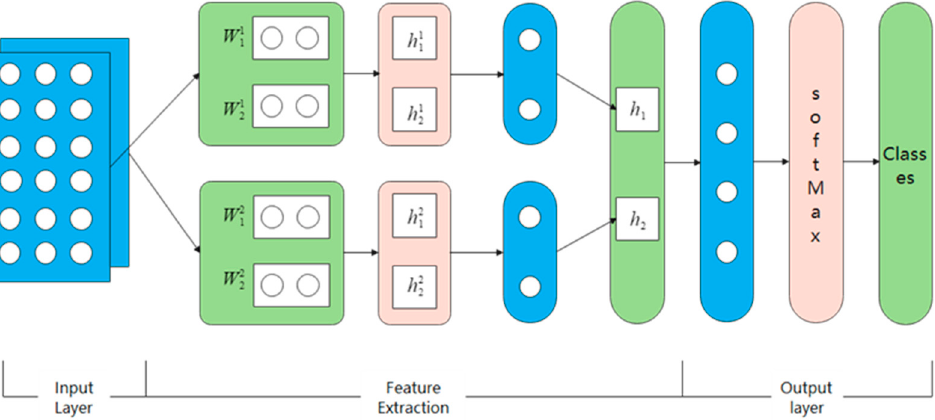
Figure 6. Flow chart of our model.